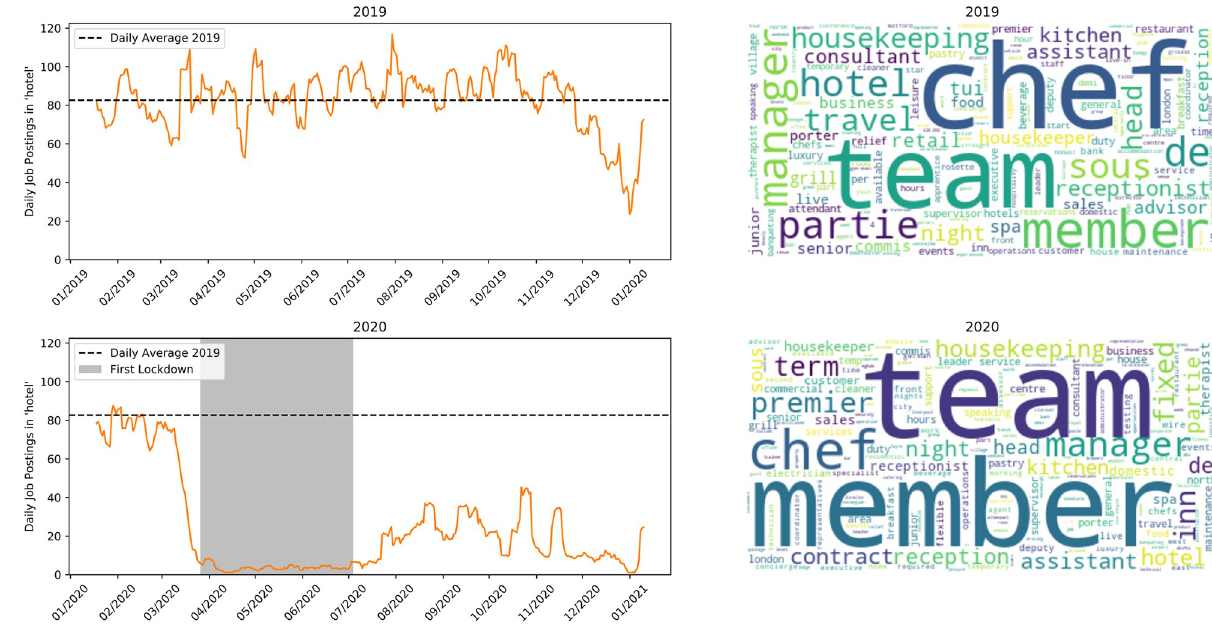
Fig 4. Jobs matching ‘hotel’. Top row is 2019, bottom is